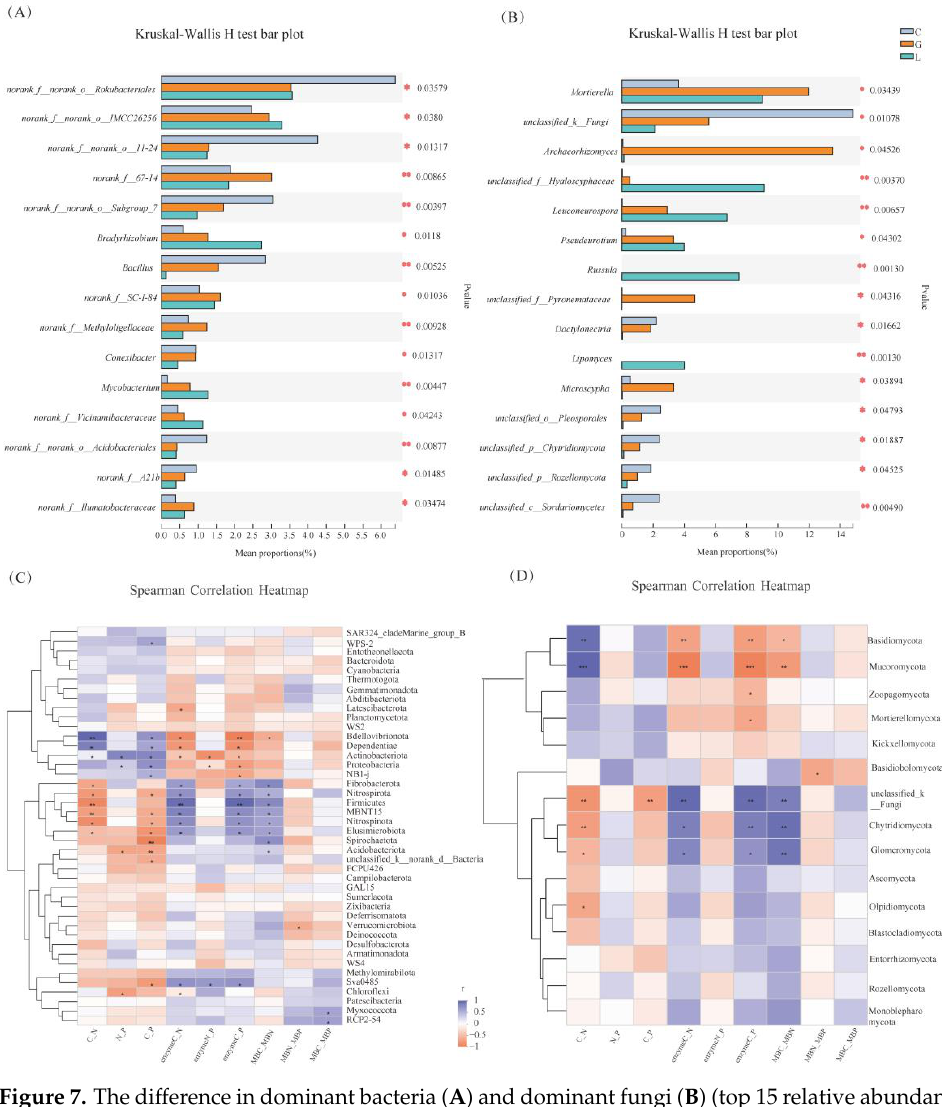
Figure 7. The difference in dominant bacteria ( A ) and dominant fungi ( B ) (top 15 relative abundances) in three planting coverts and the correlation analysis of dominant bacteria ( C ) and dominant fungi ( D ) with the stoichiometric ratio of soil nutrients, extracellular enzymes and microbial nutrients. 0.01< P <=0.05 * ， 0.001< P <0.01 ** ， P <0.001 ***